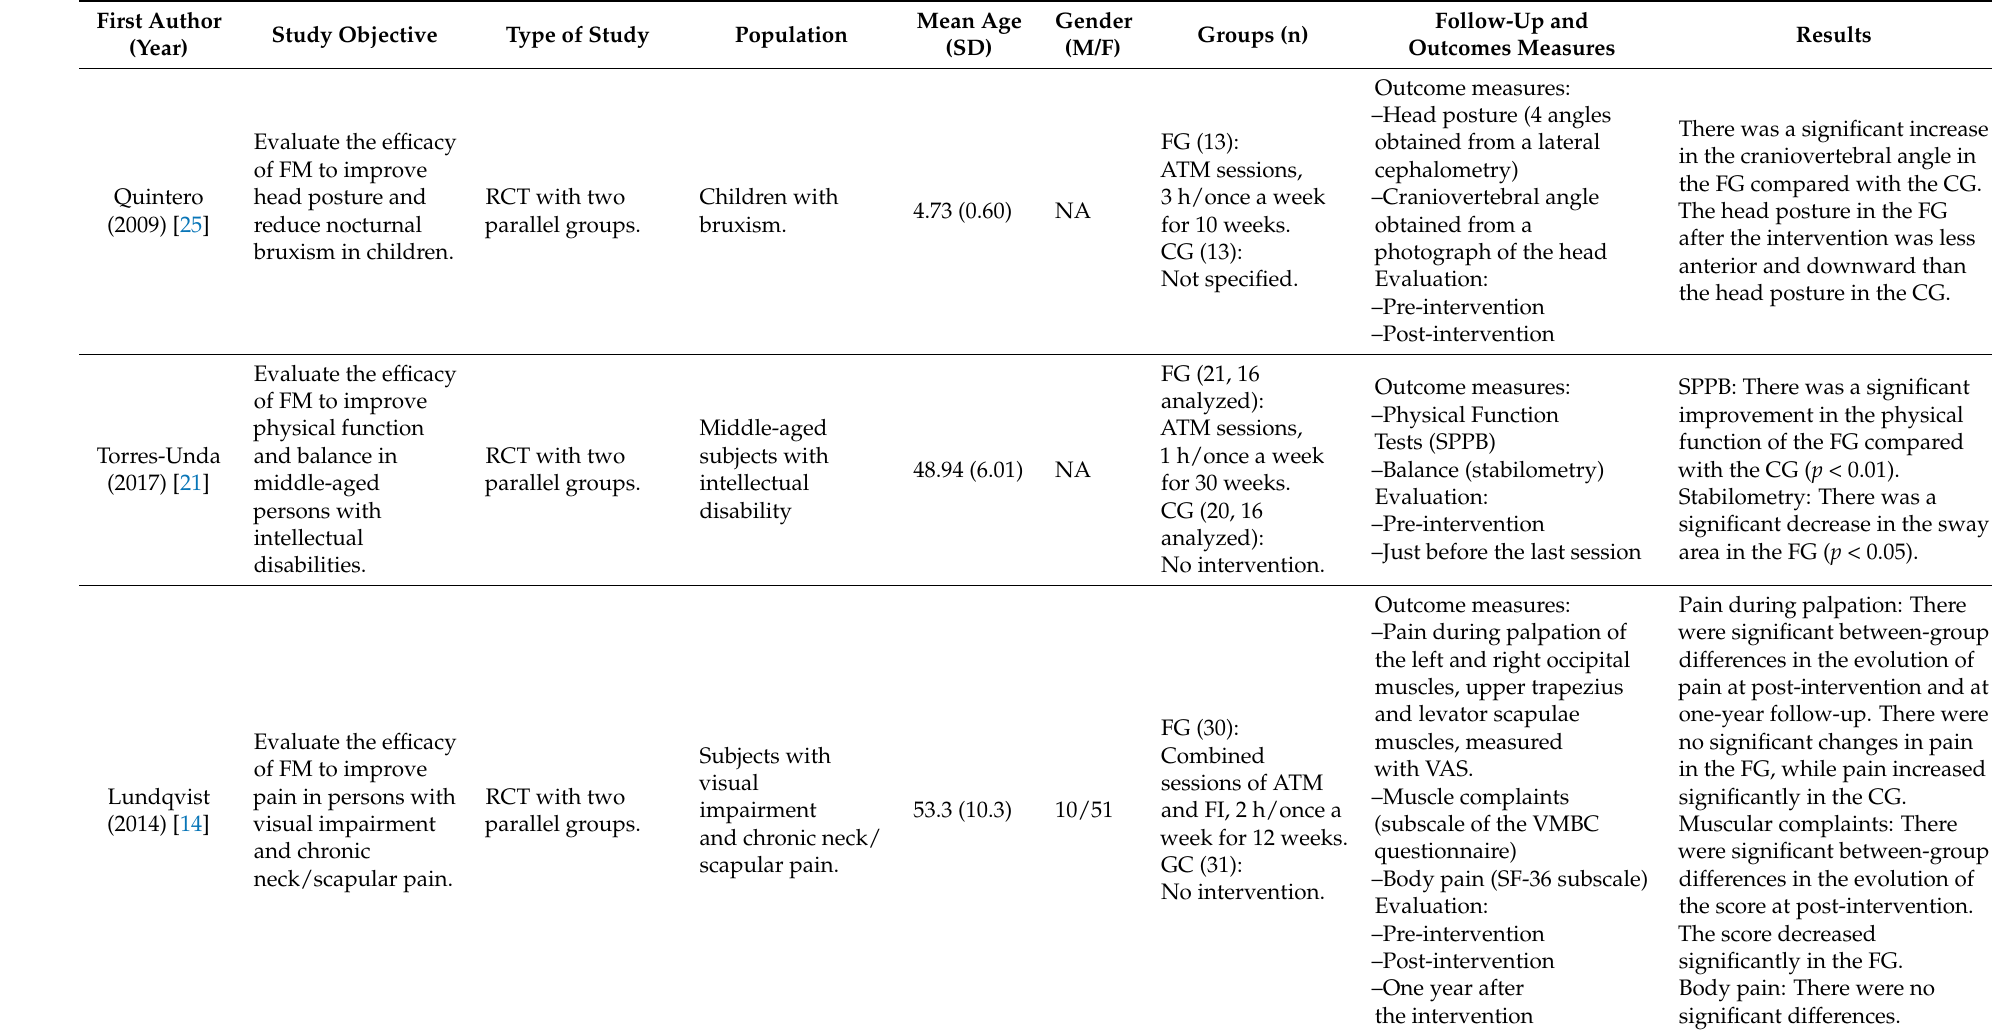
Table 2. Description of the included